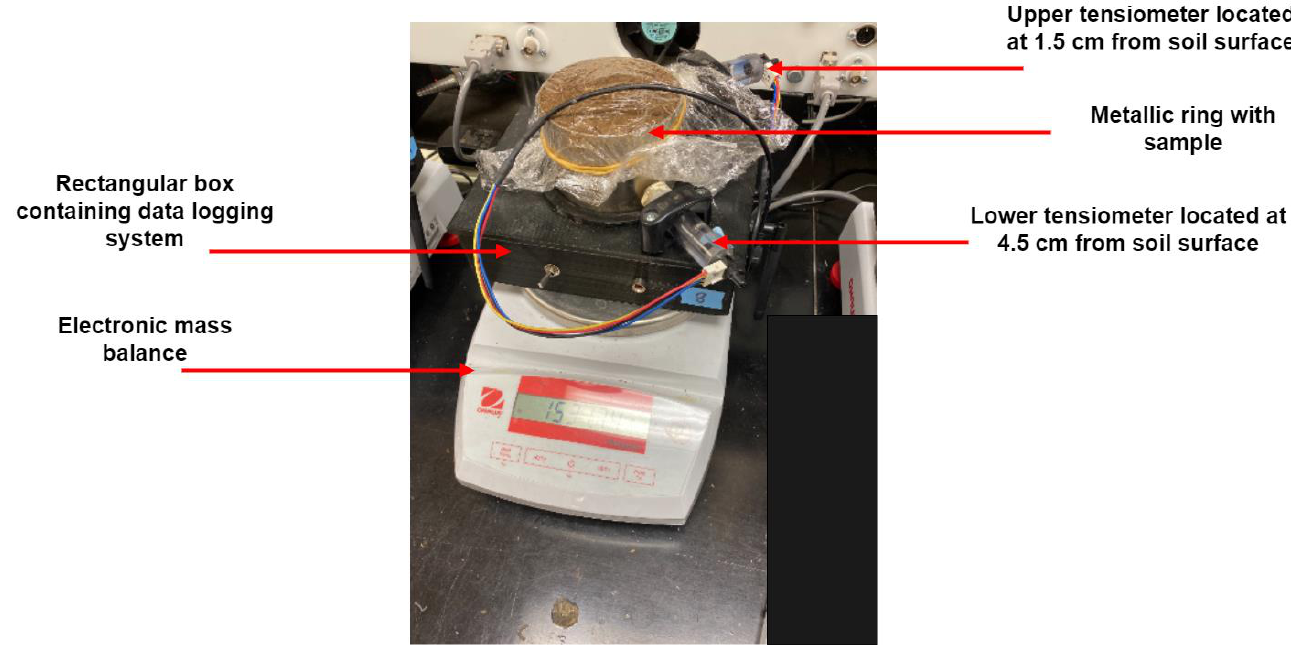
Figure 4. Image of the experimental set-up of the evaporation method used to determine the hydraulic conductivity functions K ( θ ) and K ( h ).